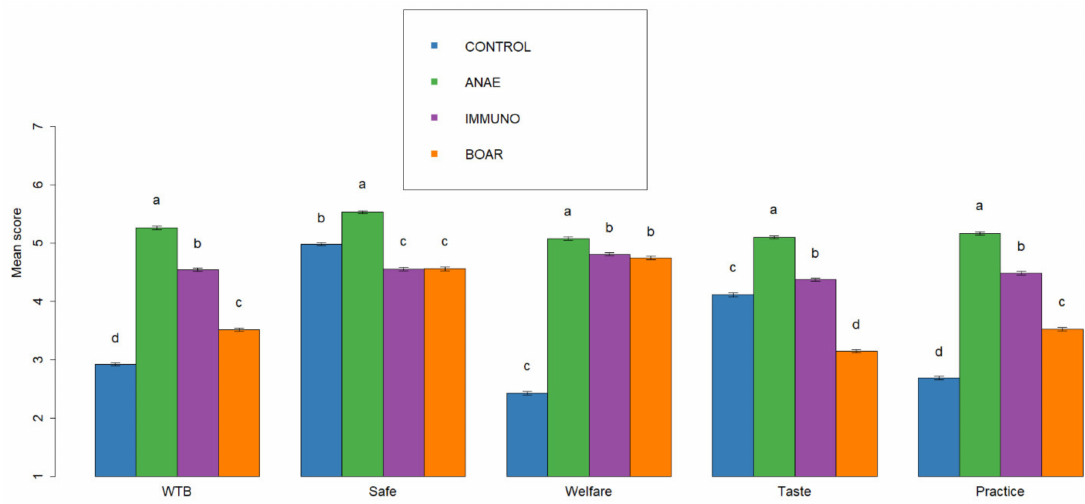
Figure 6. Overall level of agreement scored on a scale from 1 (totally disagree) to 7 (totally